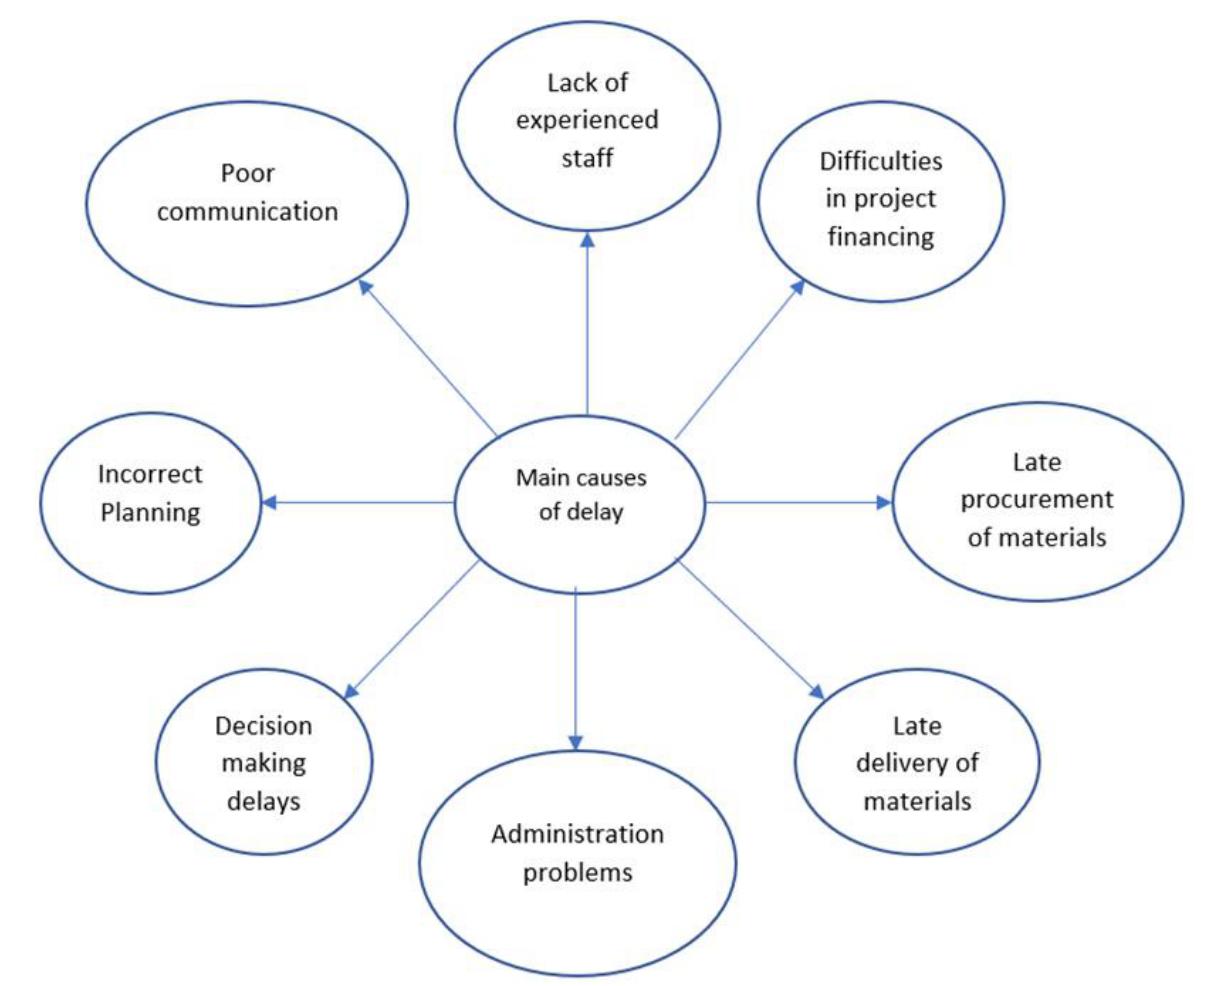
Figure 6. Main causes of delay in the Saudi Arabia construction industry.